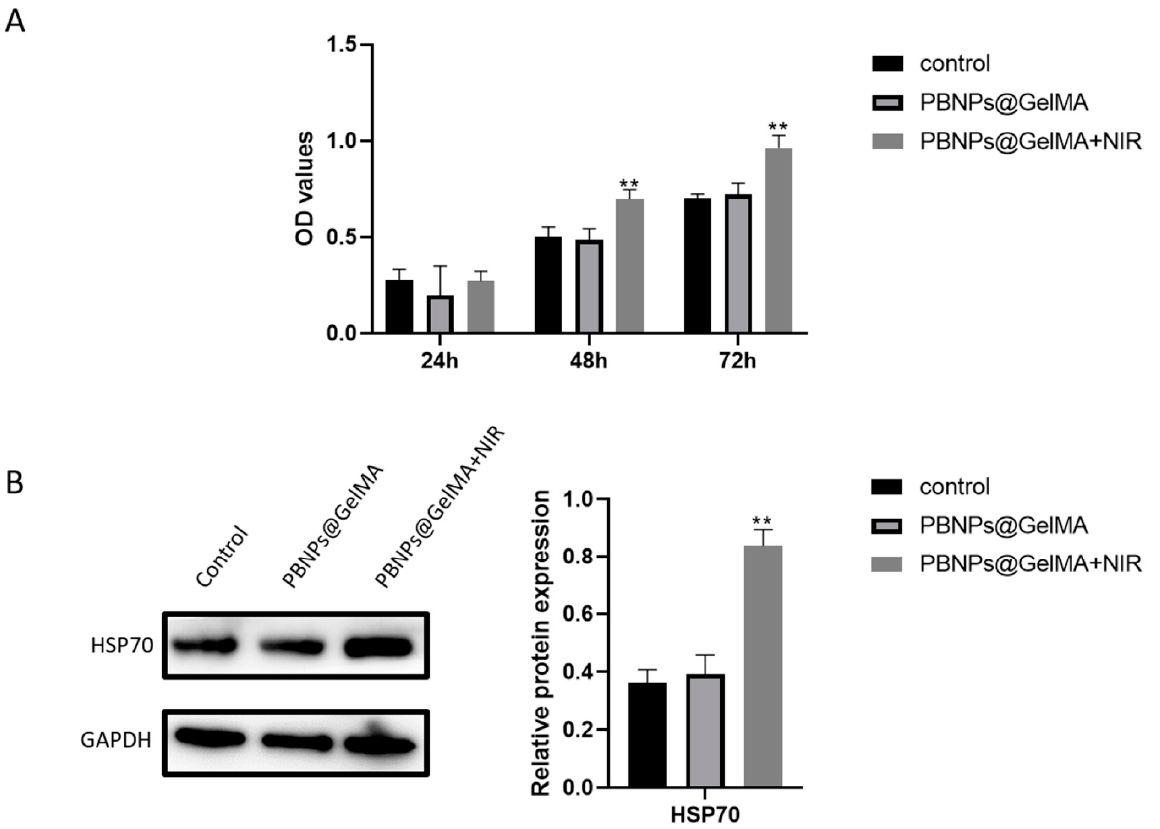
Figure 3. HSP70 played a key role in elevated cell viability of MSCs induced by heat shock treatment. ( A ) Viability of MSCs after 1, 2, and 3 days was shown by CCK8. ( B ) HSP70 expression in MSCs after heat shock treatment and associated statistics ( n = 3). Samples without implants were used as a control group; ** p < 0.01.